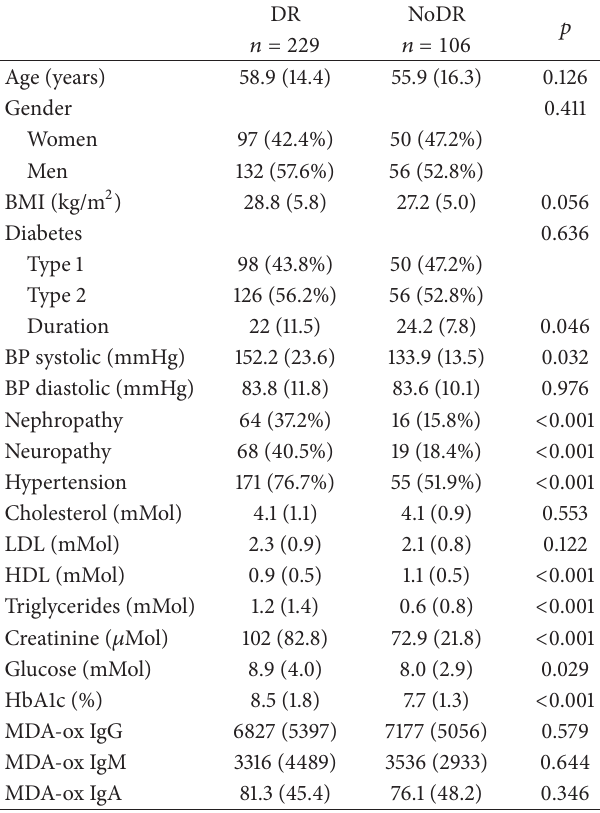
Table 1: Clinical characteristics and levels of MDA-ox LDL of dia- betic patients with diabetic retinopathy (DR) and without diabetic retinopathy (noDR). The data are expressed as mean (standard deviation (SD)) or 𝑛 (percent